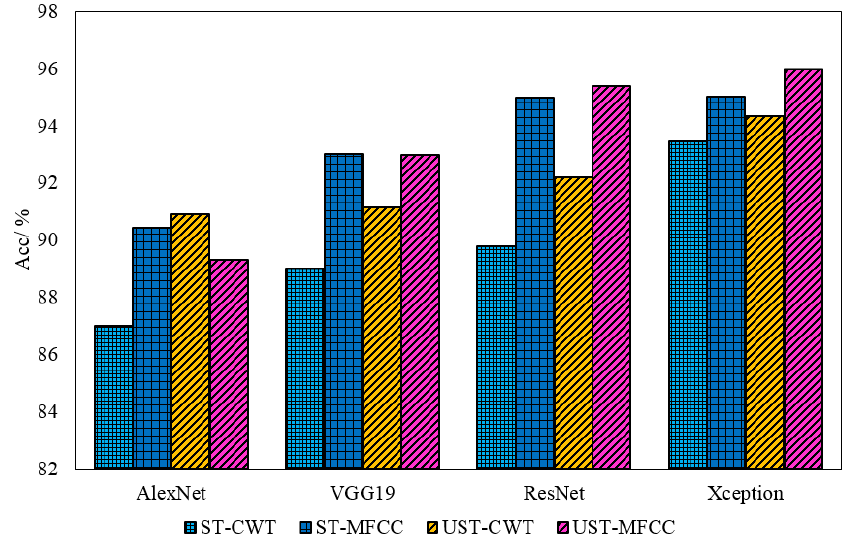
Figure 9. Comparison of the classification accuracy of four neural networks.